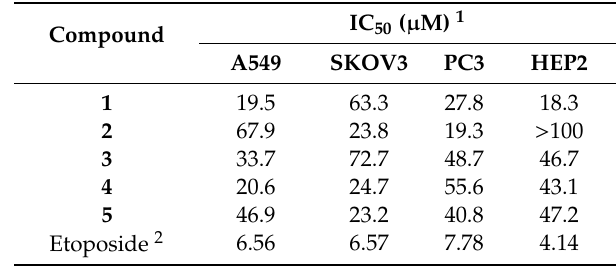
Table 1. Cytotoxicity data of compounds 1 – 5 from Trachelospermum